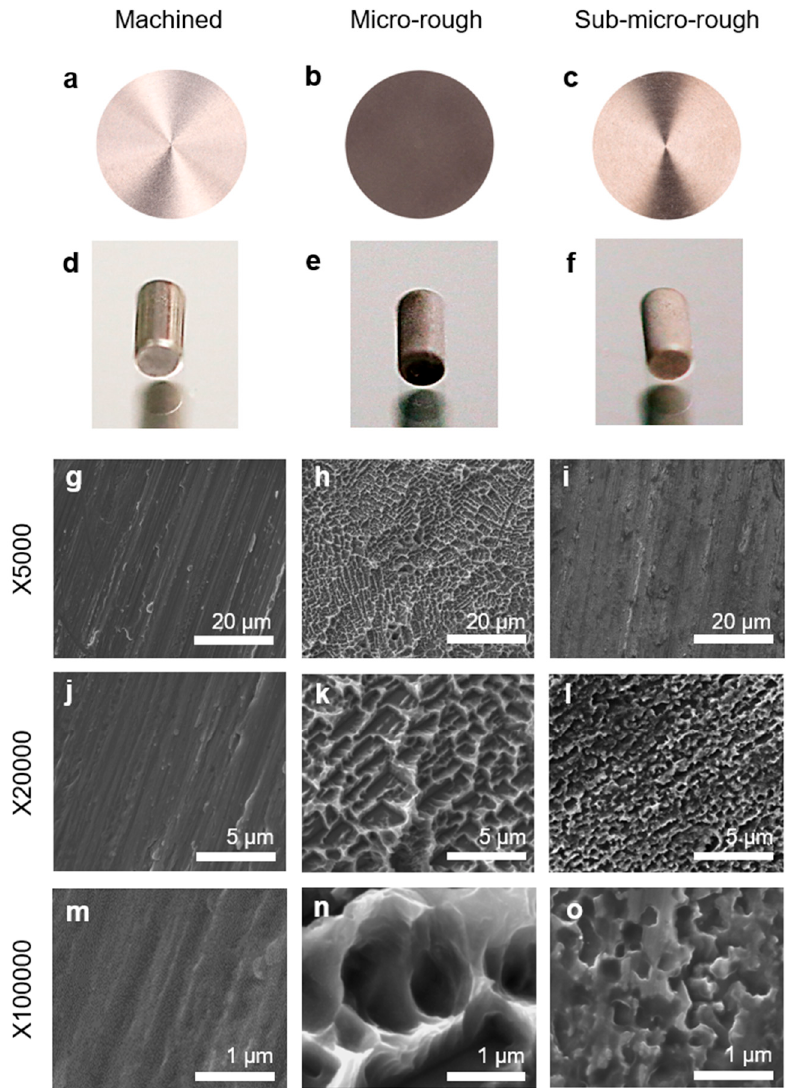
Figure 1. Surface morphology of the titanium disks and implants used in this study. ( a , d ) Macroscopic findings of the smooth surface. ( b , e ) Macroscopic findings of the micro-rough surface. ( c , f ) Macroscopic findings of the sub-micro-rough surface. Scanning electron microscopy photographs showing the surface roughness of the smooth ( g , j , m ), micro-rough ( h , k , n ), and sub-micro-rough ( i , l , o ) surfaces at magnifications of 5000 × ( g , h , i ), 20,000 × ( j , k , l ), and 100,000 × ( m , n , o ). Scale bars = ( g , h , i ) 20 µm, ( j , k , l ) 5 µm, and ( m , n , o ) 1 µm.